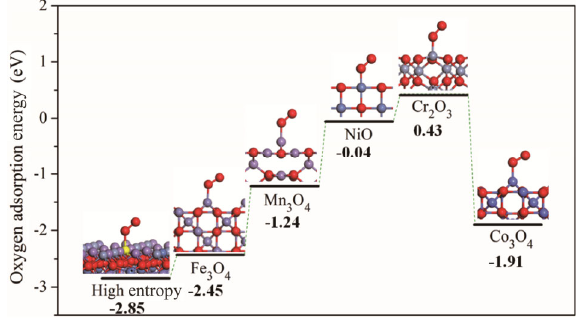
Fig. 3 Adsorption energy of O 2 on the surface of FMCNC high-entropy oxide as well as on the Fe 3 O 4 , Mn 3 O 4 , Co 3 O 4 , NiO, and Cr 2 O 3